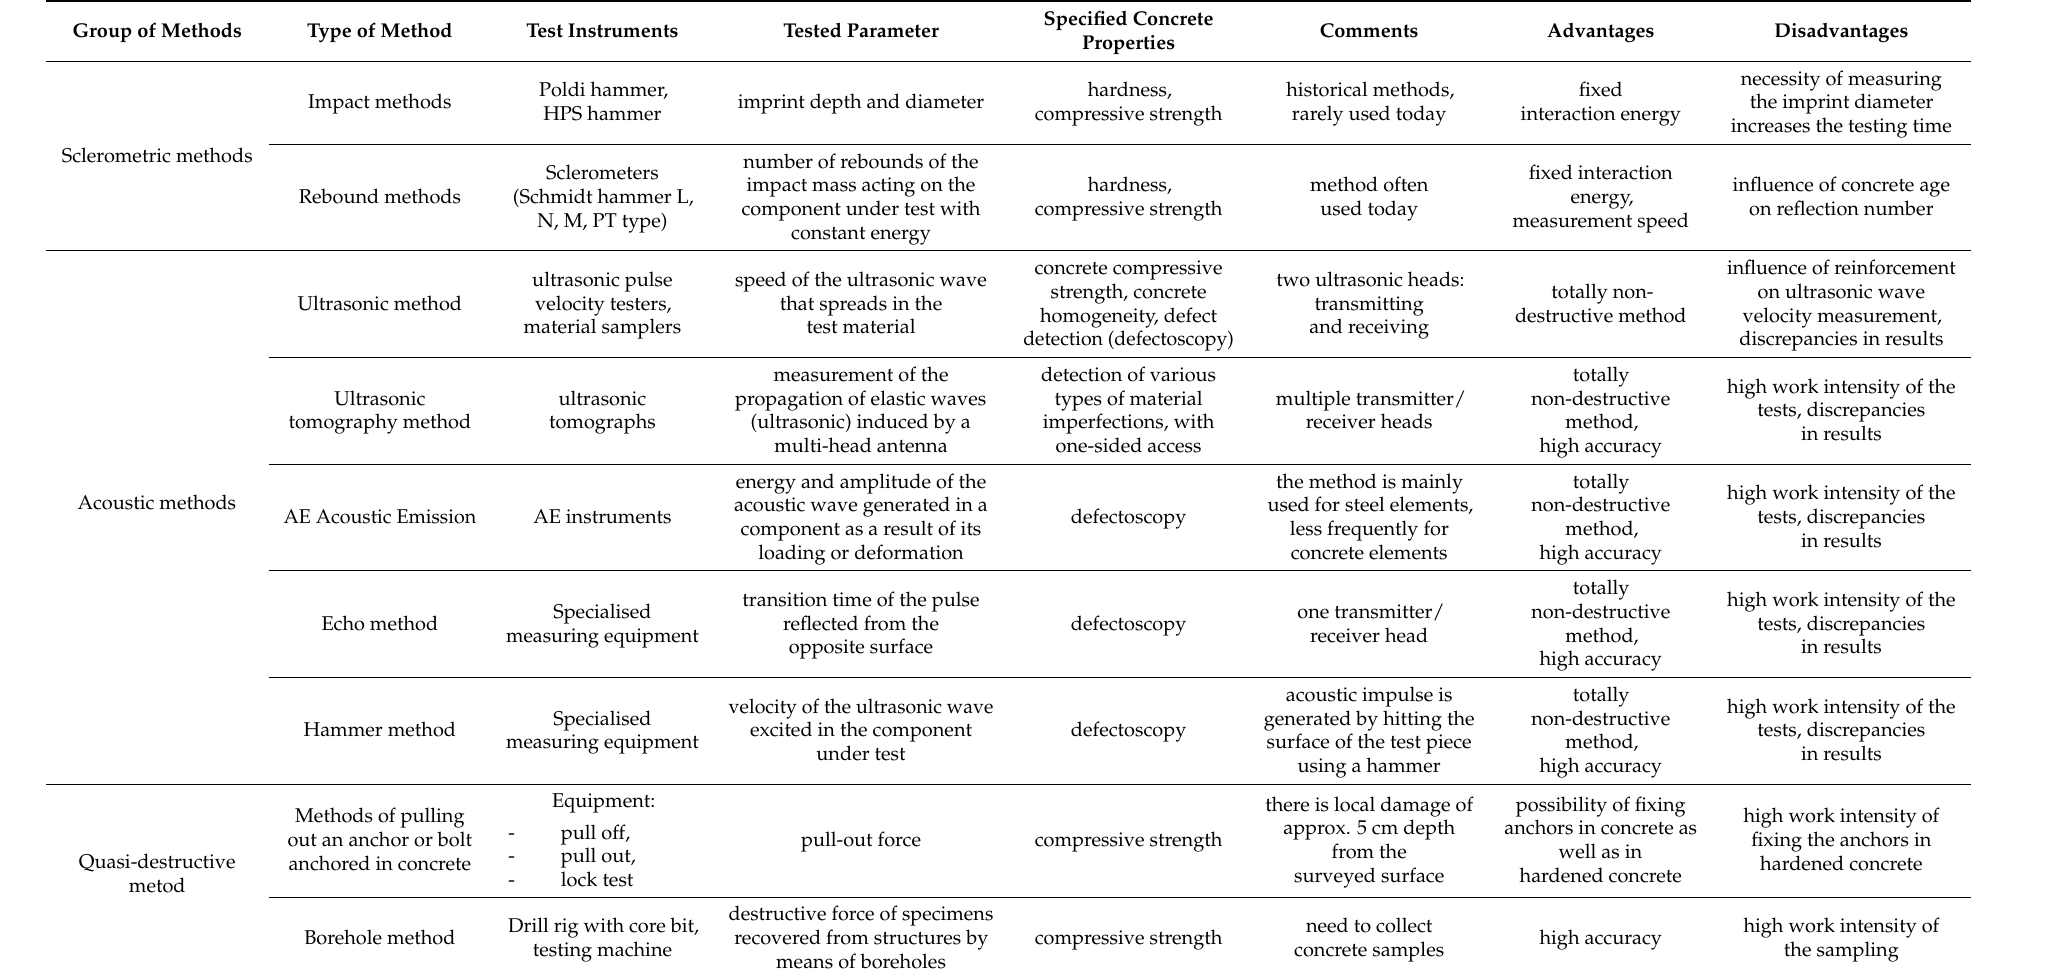
Table 1. Classification of non-destructive (NDT) concrete testing